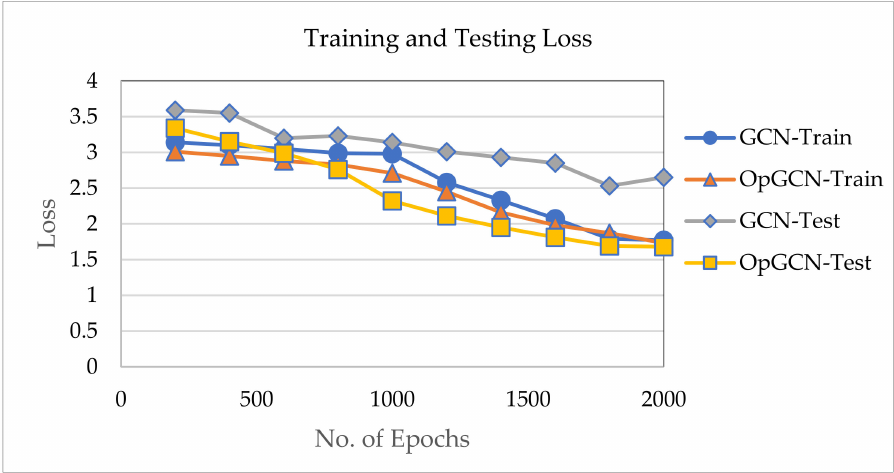
Figure 11. Epochs vs. Training and testing loss.